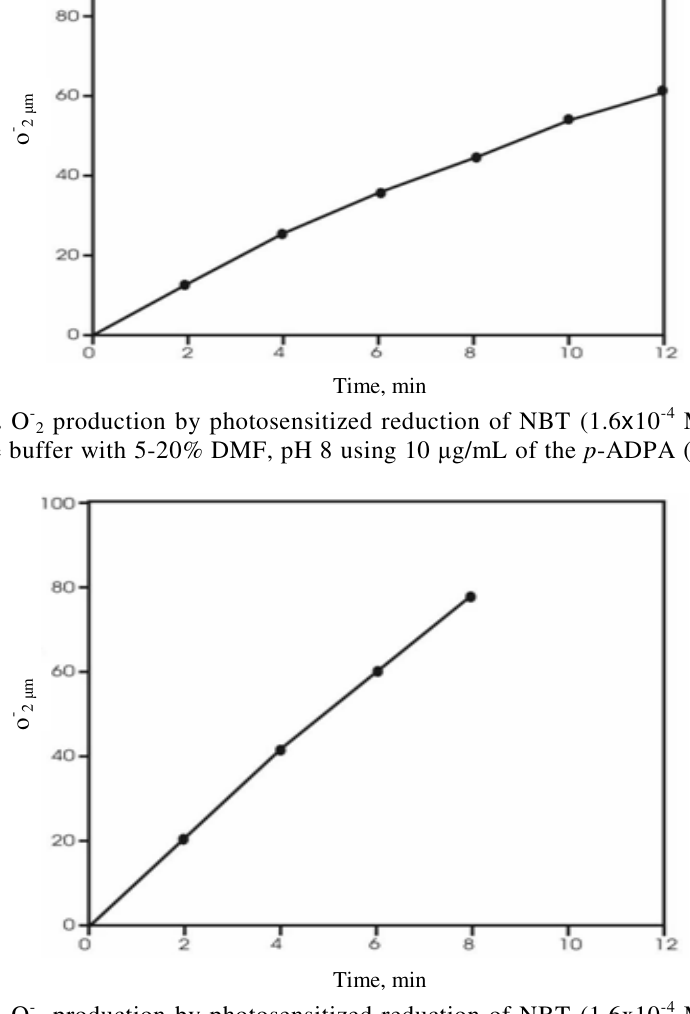
Figure 4. O - production by photosensitized reduction of NBT (1.6x10 -4 M in 0.01 M) 2 carbonate buffer with 5-20% DMF, pH 8 using 10 µ g/mL of benzanthrone (reaction time 12